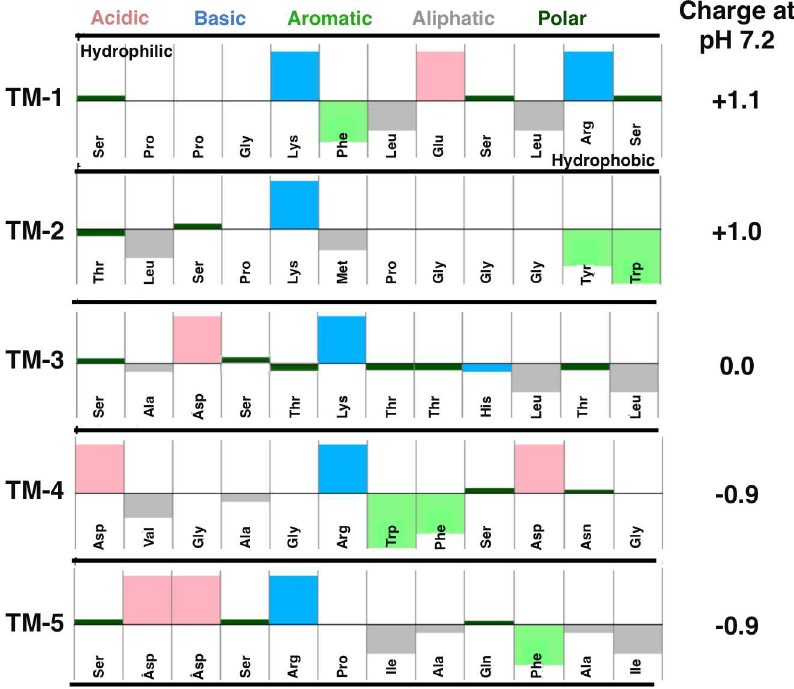
Fig 2. Composition analysis of trans-TM peptides. The peptides of five trans-TM phage exhibitinga range of TM transit efficiencieswere evaluated. PEPCALC analysisof amino acid characteristics and hydrophility/ hydrophobicity ( A ) and isoelectricproperties( B